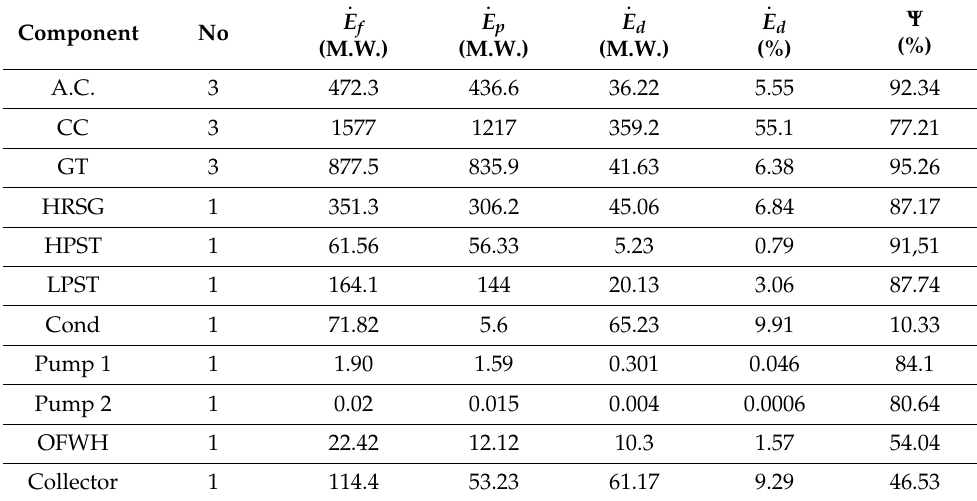
Table 9. Exergy analysis of the ISCC